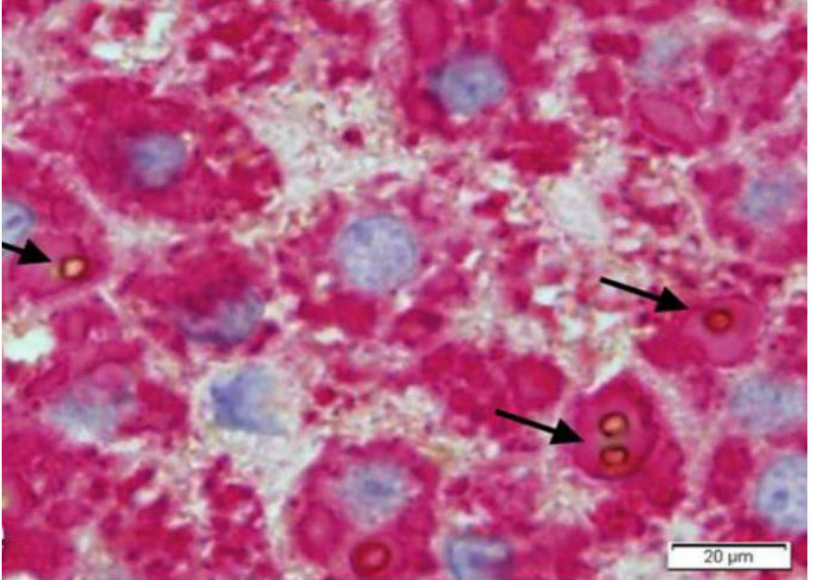
Figure 18. Liver tissue section from a patient with HHHS and hypo-APO-B- lipoproteinemia. All hepatocytes contain fibrinogen immunoreactive inclusions (red color). Round brown inclusions (arrows) represent lipid material inside fibrinogen inclusions. The periphery of lipids shows a positive immunoreaction to an anti-APO-B-lipoprotein antibody (double immunostaining, original magnification × 60). Figure obtained from Callea F et al. IJMS 2021; 22: 2899.